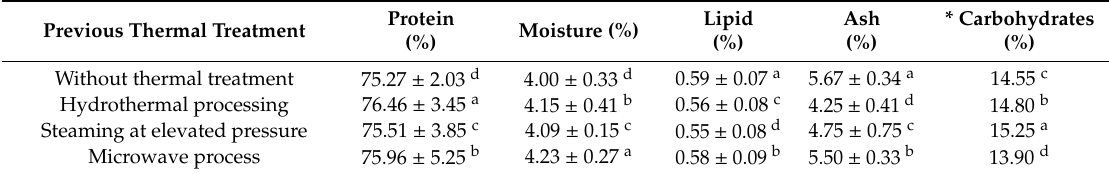
Table 1. Chemical composition of the pacaya protein isolates obtained of flour with di ff erent thermal